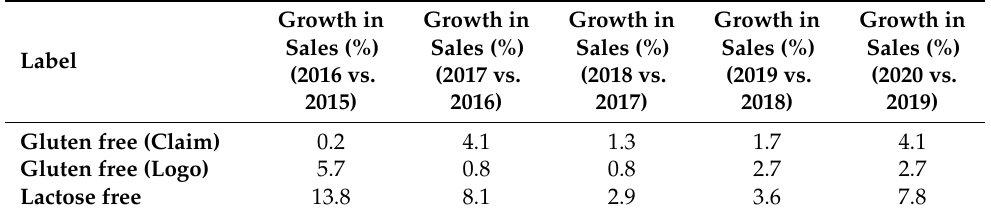
Table 1. Percentage growth in sales (%) of LF products compared to gluten-free products